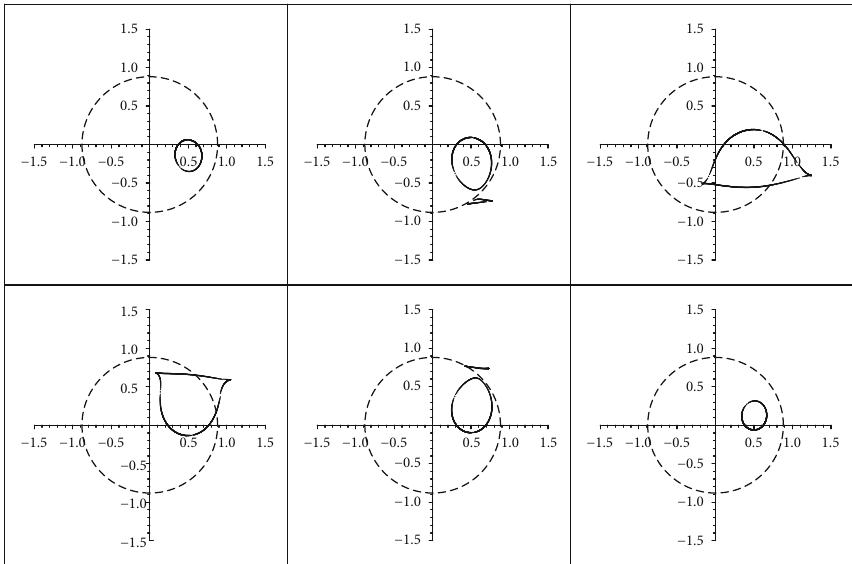
Figure 6: Points on the wave front of constant time for null geodesics emitted from a point away from the origin in the Gödel metric. The wave fronts develop blue sky bifurcations outside the circle for which the observer at the origin can